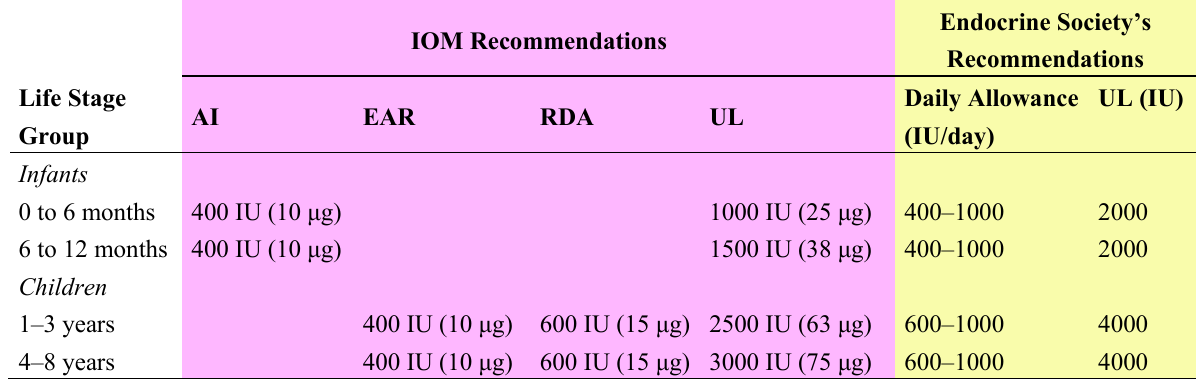
Table 2. Recommendations of the Institute of Medicine and the Endocrine Society Practice Guidelines for daily vitamin D supplementation to prevent vitamin D deficiency. This table is reproduced with permission from [16], Copyright © 2011 The Endocrine